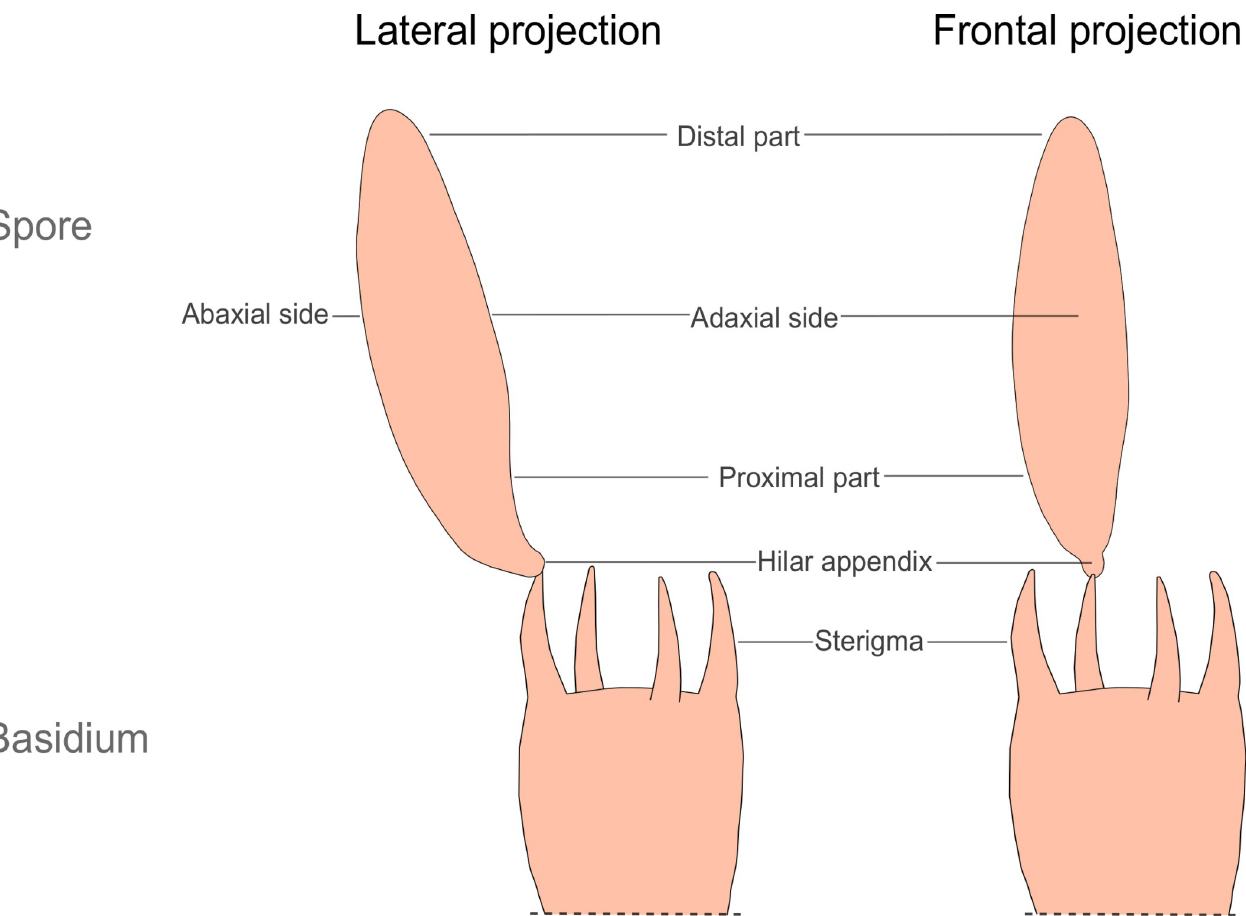
Fig 1. Crucial terms for describing a spore of the member of Agaricomycetes. For simplicity, only the upper parts of basidia and only one spore per basidium instead of four are shown.